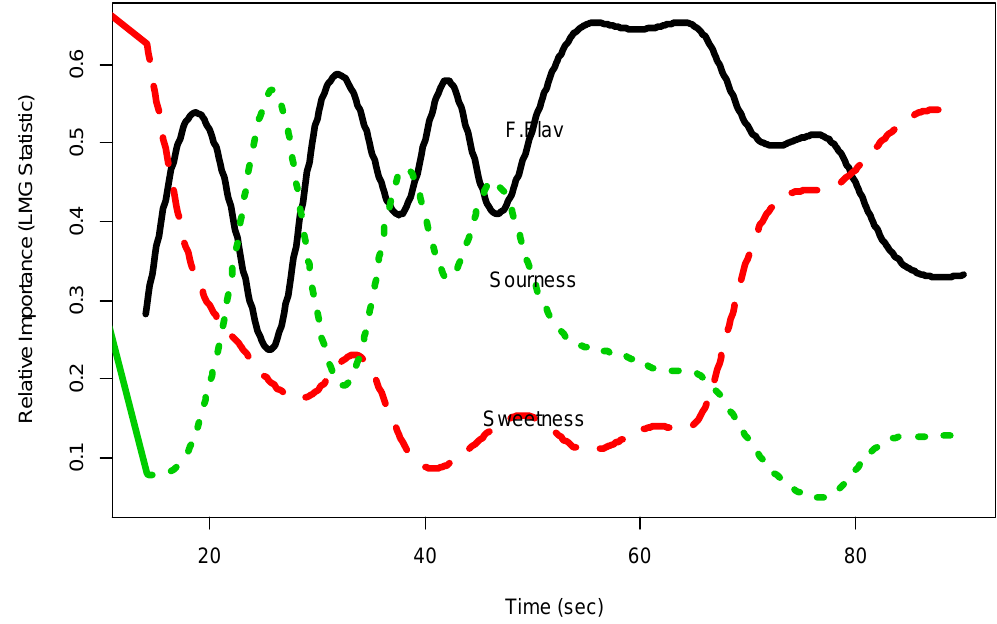
Figure 9. Temporal drivers of Overall Liking of Texture with just-about-right scale.